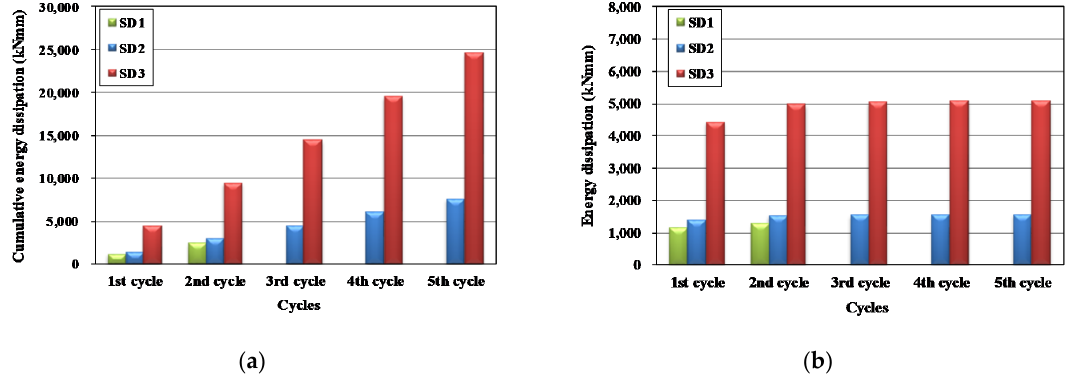
Figure 7. Energy dissipation of tested specimens: ( a ) Cumulative energy dissipation; ( b ) Energy